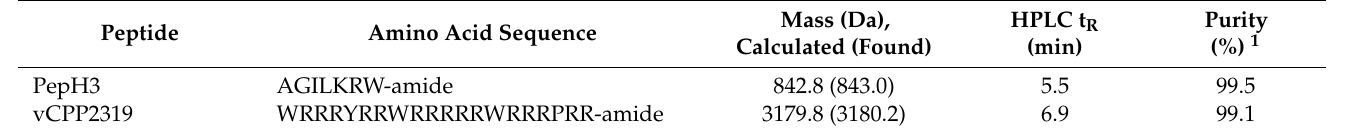
Table 1. Peptides used in this